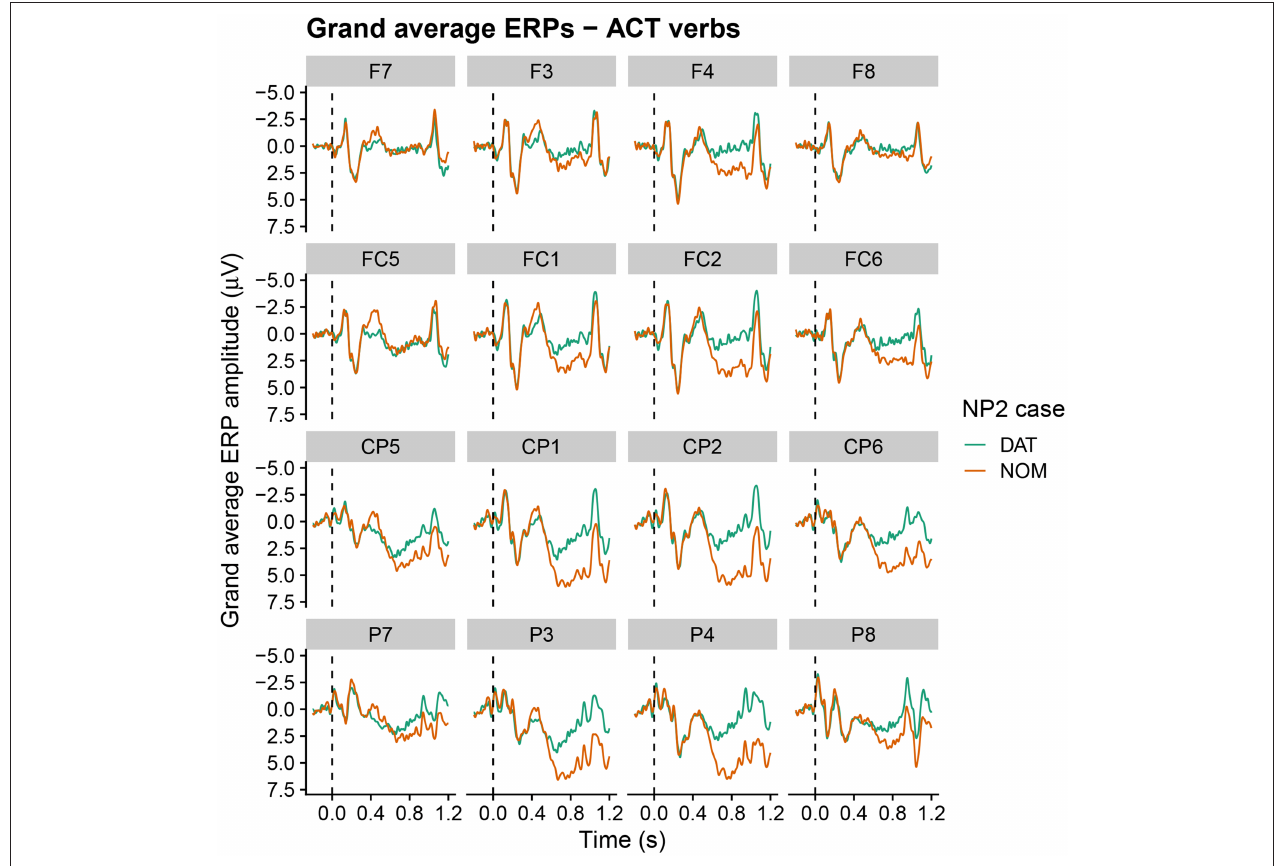
FIGURE 3 | Grand average ERPs at the critical NP2 position for sentences with active verbs (onset at the dashed vertical line). Negativity is plotted